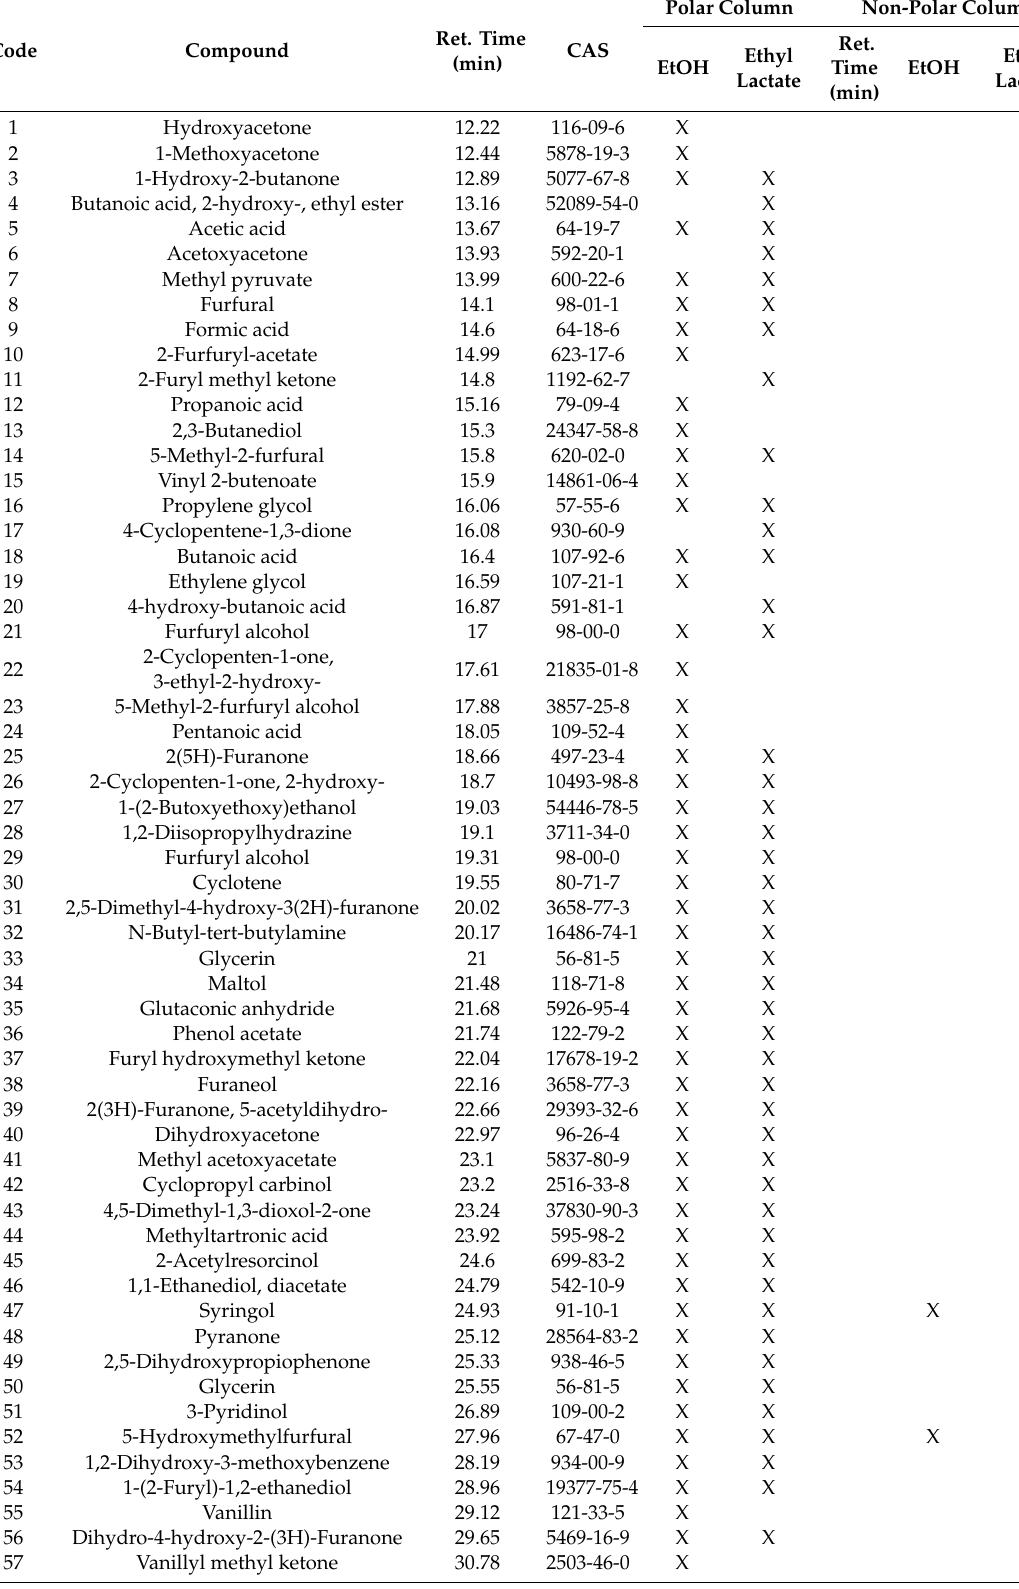
Table 4. Identified compounds in the ethanolic and ethyl lactate extracts obtained from the concentrate of Eucalyptus. GC-MS